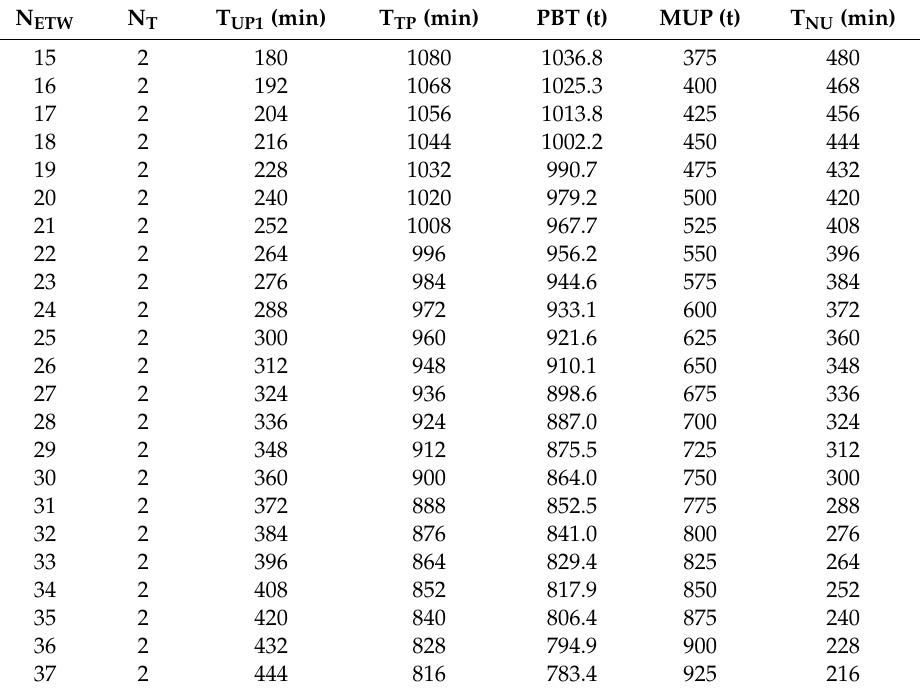
Table 7. Results for the second iteration with E = 0.84 and Q = 576